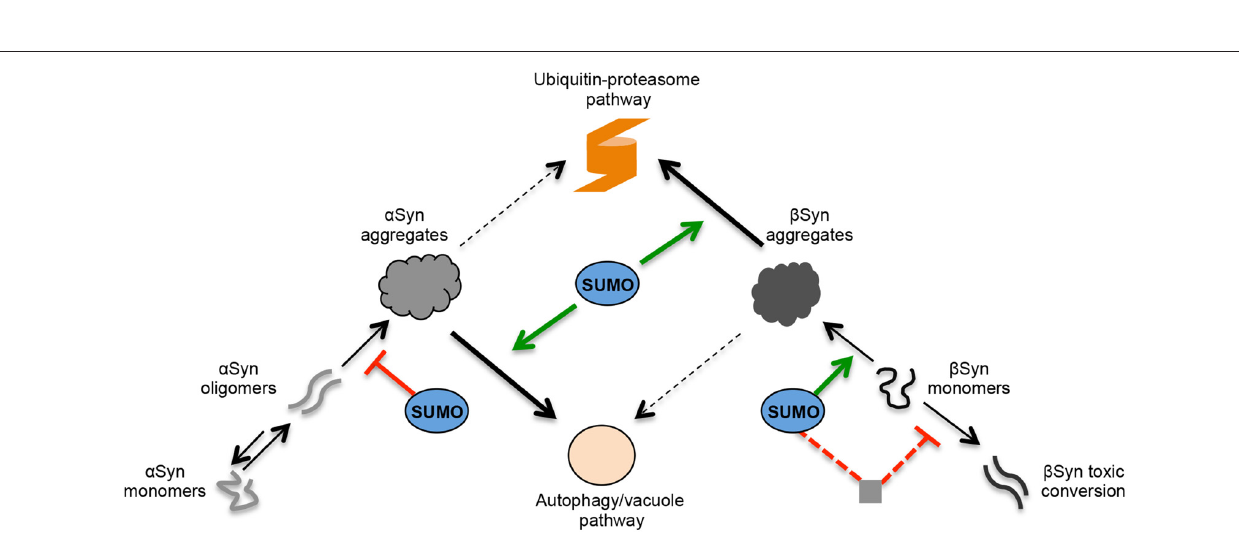
FIGURE 8 | Role of SUMO in the regulation of α Syn and β Syn turnover and toxicity in yeast. Schematic representation of α Syn and β Syn aggregation pathways. Under pathological conditions, α Syn can undergo oligomerization. A dynamic equilibrium exists between monomeric and multimeric forms of α Syn. The oligomeric species represent intermediates of the aggregation process and are suggested to be the most toxic forms of α Syn. SUMO exhibits a protective role against α Syn-induced toxicity. Sumoylation increases the solubility α Syn and decreases the aggregation of the protein. In contrast, β Syn aggregate formation and cytotoxicity are part of different molecular mechanisms. A fraction of accumulated β Syn might gradually undergo structural conversion and form toxic oligomers or fibrils. In contrast to α Syn, these might not be intermediate species in the aggregation process but might be part of an independent molecular pathway. Sumoylation of β Syn promotes the aggregate formation of the protein without affecting the cytotoxicity. The presence of functional cellular sumoylation machinery protects against β Syn toxicity independently of β Syn sumoylation. Sumoylation of additional target proteins or cellular pathways might be involved in the cytoprotection by inhibiting the formation of β Syn toxic species. α Syn and β Syn aggregates are cleared predominantly by two different pathways. The main pathway for α Syn aggregate clearance is autophagy, whereas ubiquitin-proteasome system (UPS) is the major degradation pathway for β Syn aggregates. Autophagy/vacuolar pathway has a minor contribution to β Syn aggregate clearance. Presence of functional SUMO protects against β Syn as well as α Syn toxicity by promoting the degradation of the proteins. Sumoylated α Syn is primarily targeted to the autophagy pathway, whereas presence of functional SUMO promotes the degradation of β Syn monomers and β Syn aggregates by the ubiquitin-proteasome